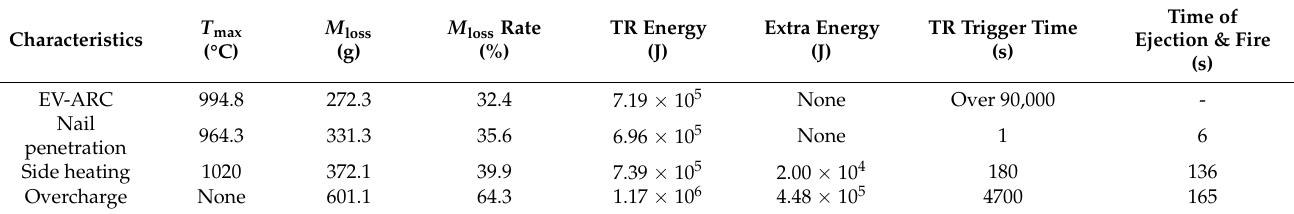
Table 2. Characteristic parameters of cell TR under different abuse